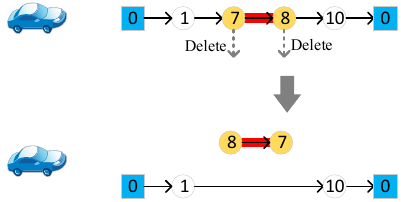
Figure 5. Change the access direction of a target edge assigned to the vehicle. Different numbers in the figure represent different nodes of the road network.